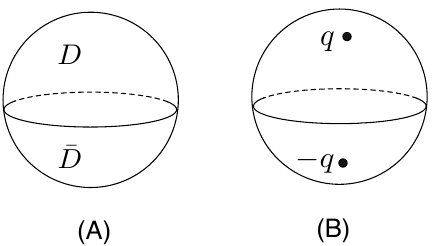
Figure 4 . (A) The spatial 2-sphere partitioned into two discs D and (cid:22) D . (B) The 2-sphere with an anyon q in D and q in (cid:22) D (cid:0)